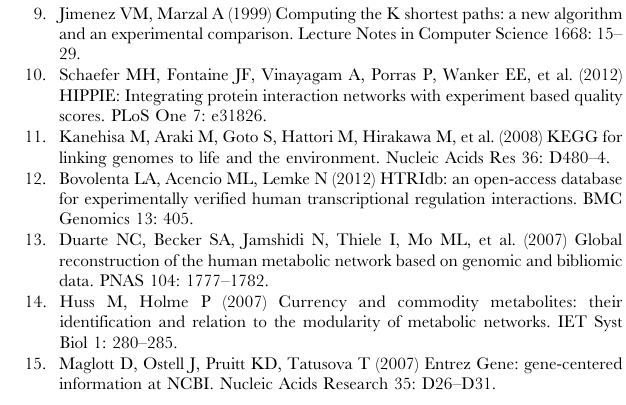
Figure S1 The MET ? JUN subnetwork. This subnetwork contains 116 interactions. The highlighted solid edges represent the interactions present in the corresponding OLP. The highlighted dashed edges represent the interactions of the potential oncogenic pathway (MET ? STAT3 ? JUN). Blue edges represent protein physical interactions and orange nodes represent genes participating in the known or potential oncogenic pathways.